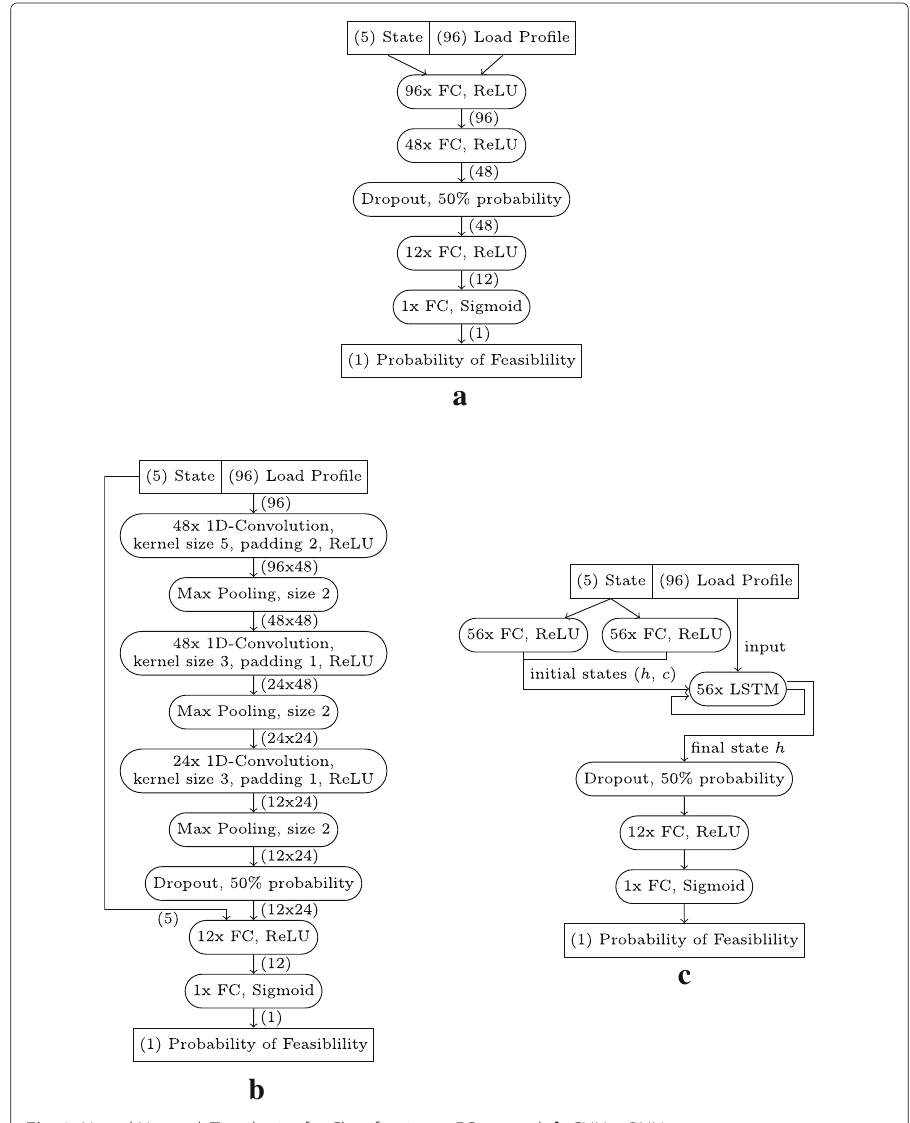
Fig. 3 Neural Network Topologies for Classification. a FC network, b CNN, c RNN In detail, the state consists of a one-hot-encoded season vector (winter, intermediate, or summer) followed by the state of charge of the CHP plant’s hot water tank and the state of charge of the BESS. If the modeled setup does not contain a CHP plant or BESS, the particular SoC is always set to